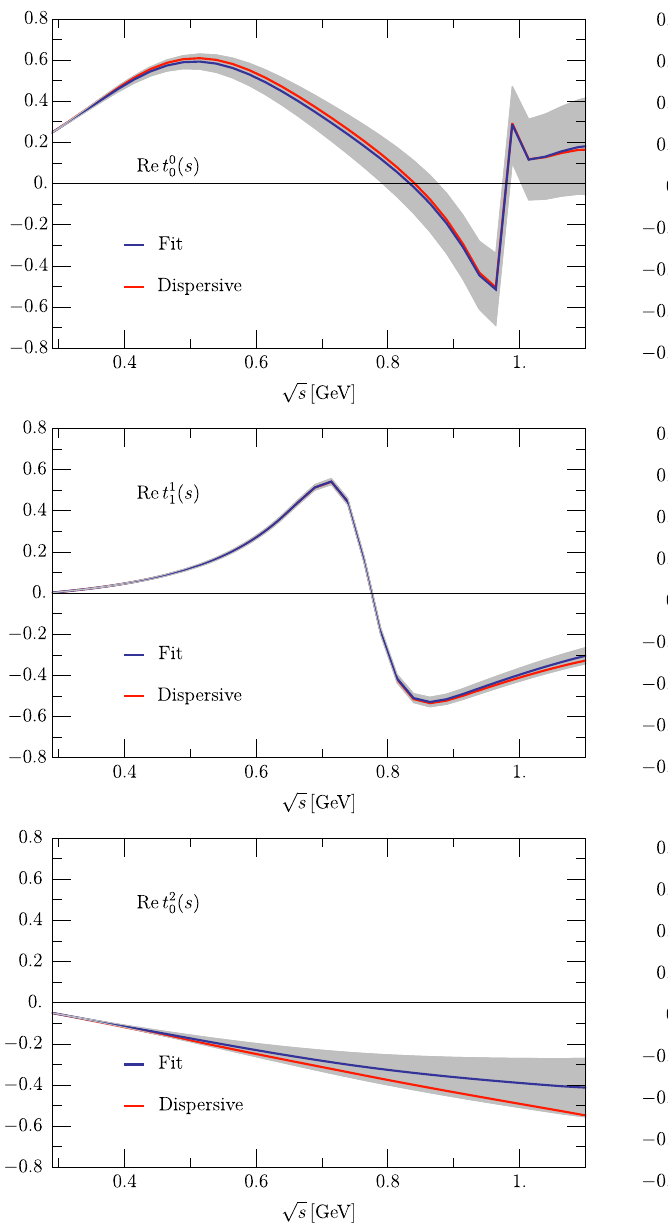
Fig. 6 ResultsforRoyequations.Bluelines:realpartcomingfromour new parameterizations. Orange lines: the result of the dispersive inte- grals. The gray bands cover the uncertainties in the difference between both. From top to bottom: a S 0 wave, b P wave, c S 2 wave